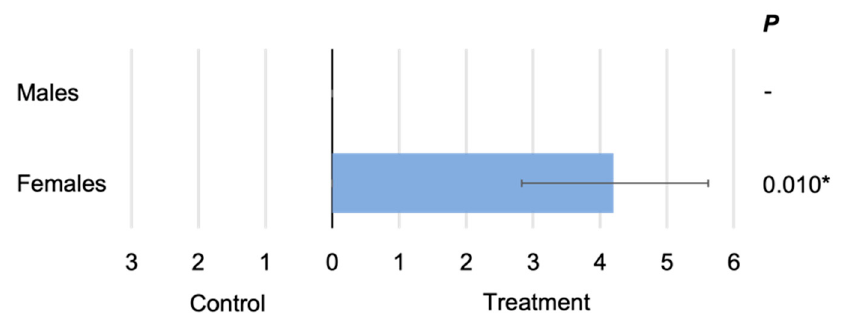
Figure 2. Male and female responses to worn and control socks. The blue bar represents the mean number (±SE) of individuals trapped in the test (worn sock) or control chamber. The sex of the tested mosquitoes is indicated on the left of the graph and the associated paired, two tailed t test p values are on the right (* p < 0.05).